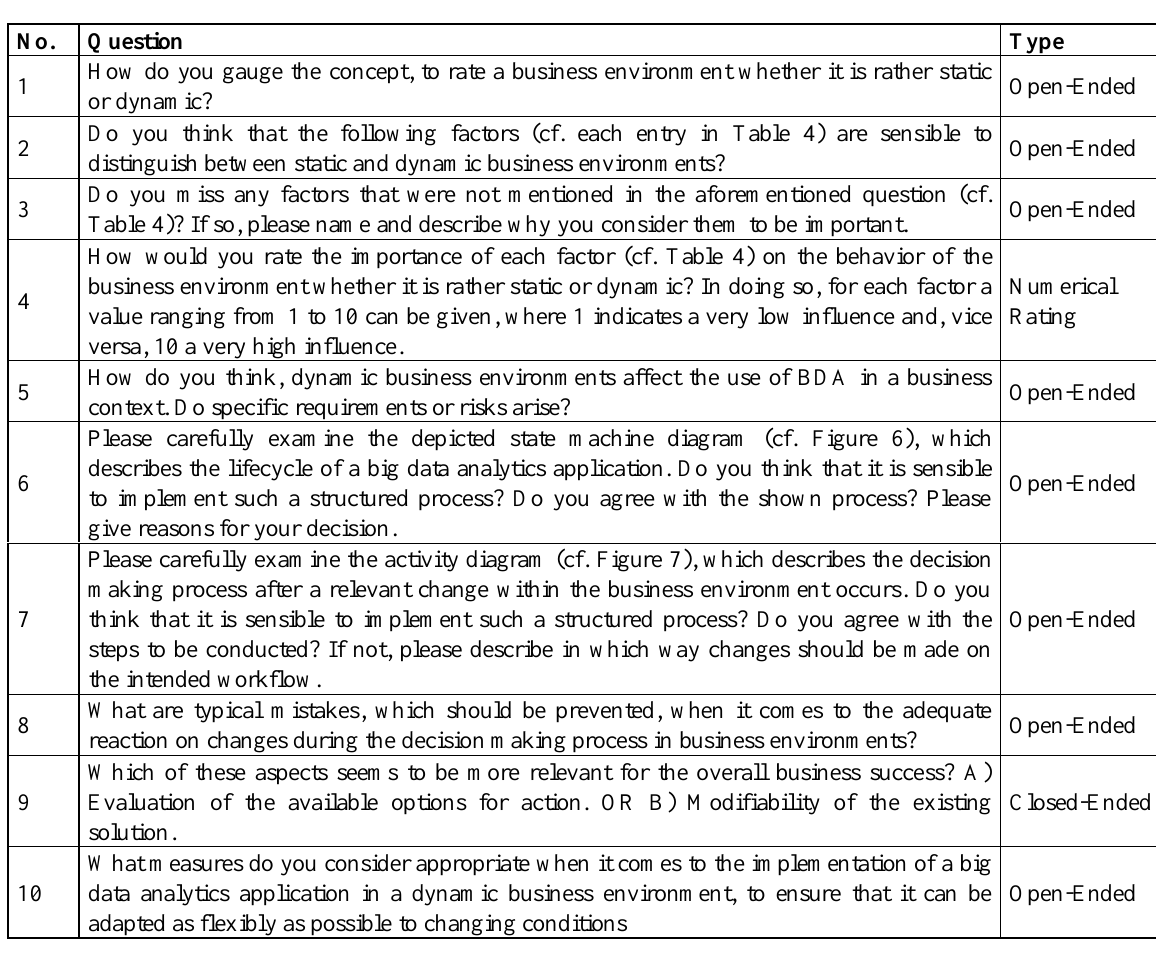
Table 3. All asked questions and their respective answer